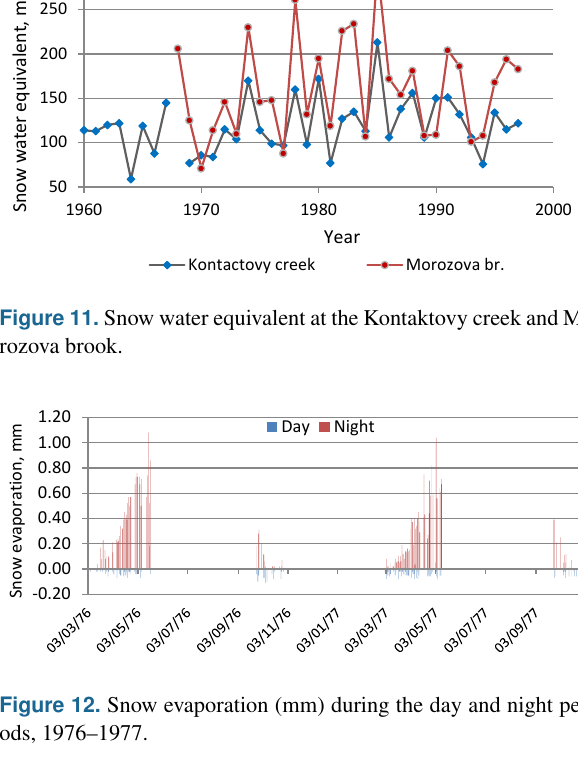
April – + 0.40; May – + 0.74; September – + 0.20; October 1977 are presented in Fig.